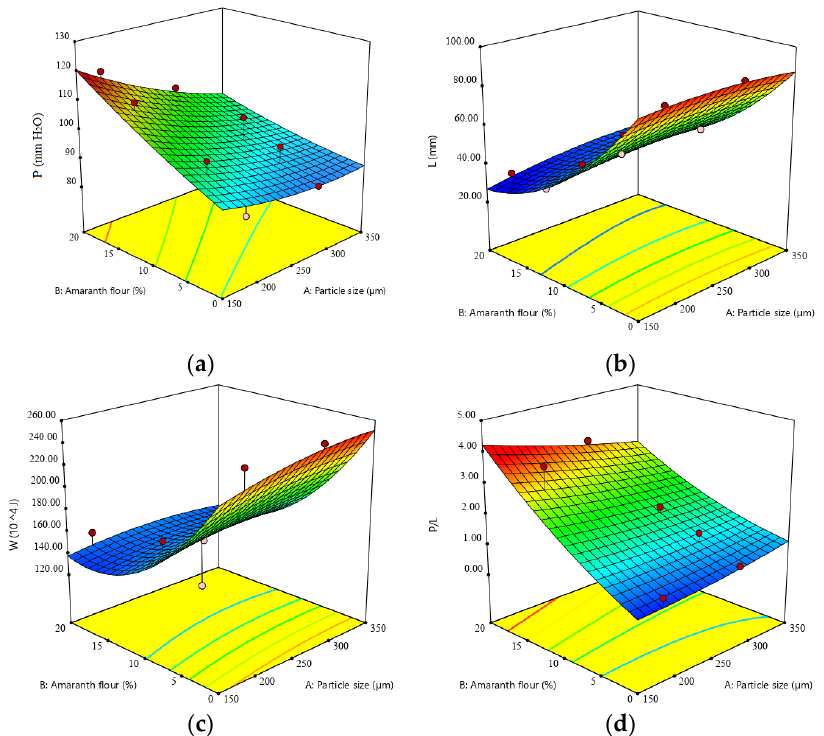
Figure 3. Three-dimensional response surface plots showing the interaction between amaranth flour particle size and addition level on: ( a ) dough tenacity (P); ( b ) dough extensibility (L); ( c ) dough strength (W); and ( d ) alveograph configuration ratio (P/L).